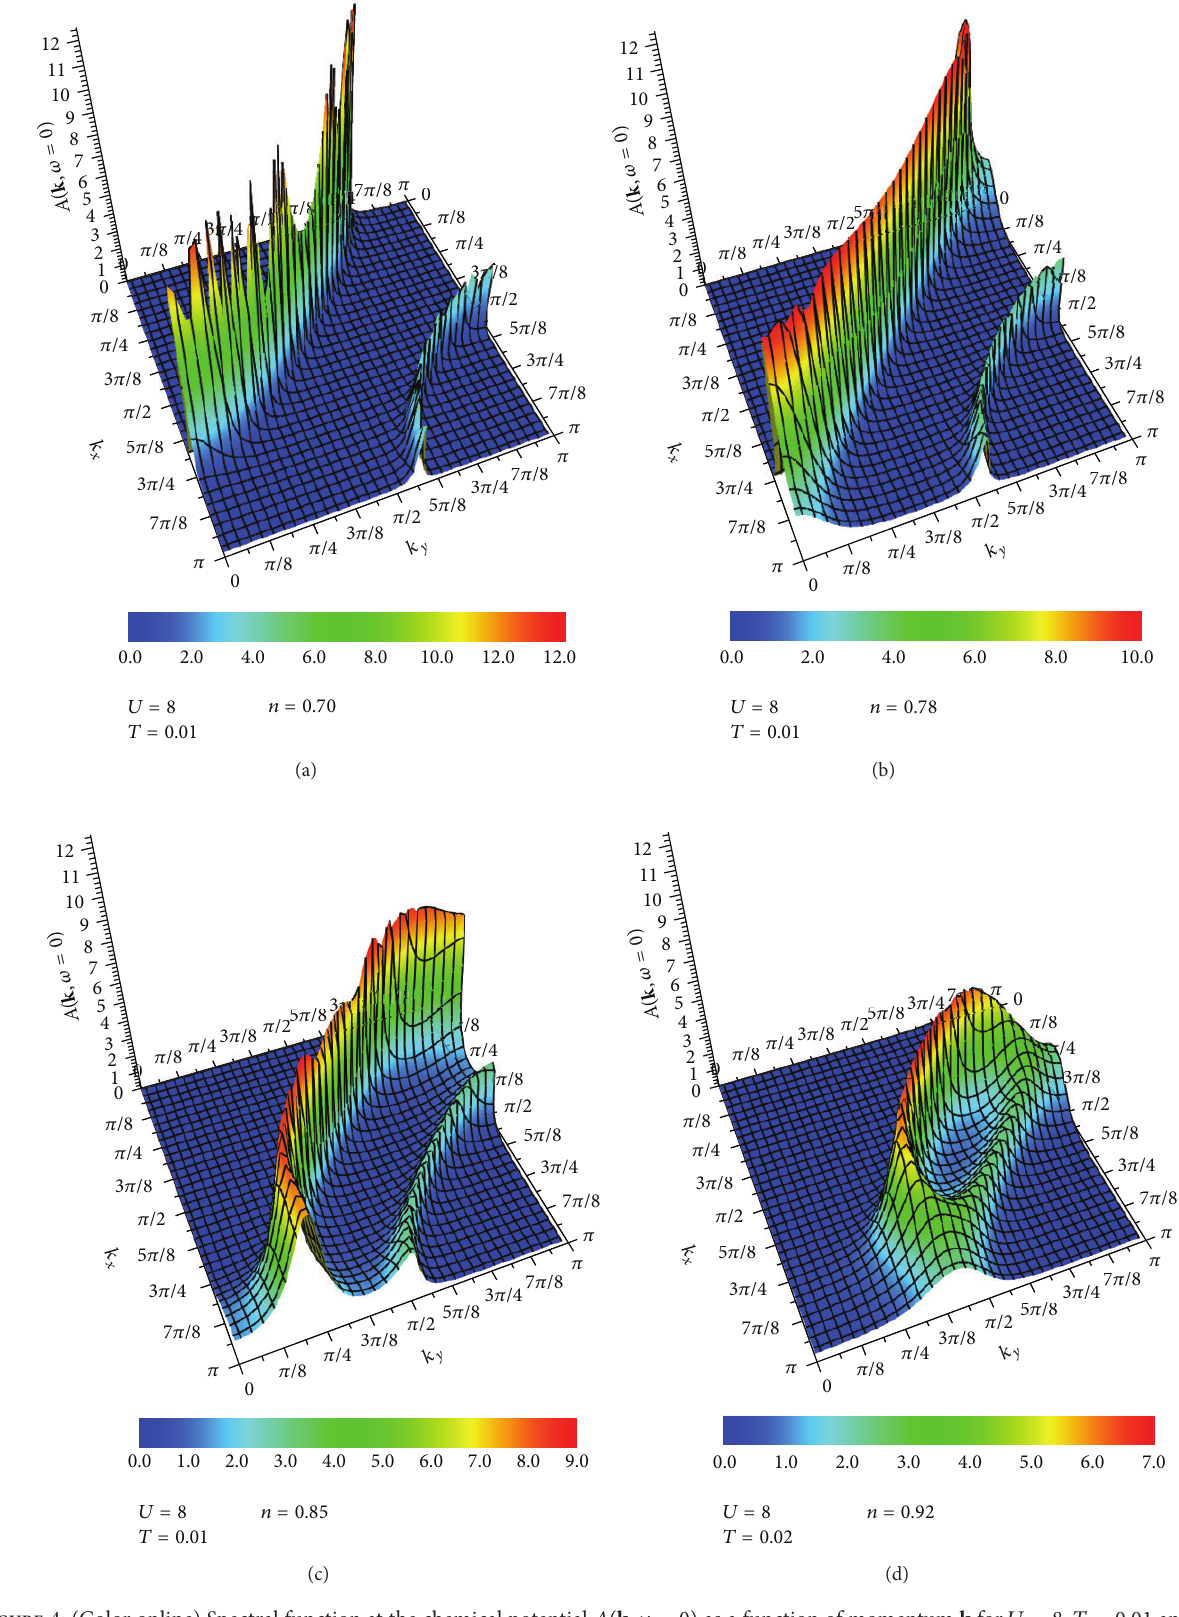
Figure 4: (Color online) Spectral function at the chemical potential 𝐴( k , 𝜔 = 0) as a function of momentum k for 𝑈 = 8 , 𝑇 = 0.01 and (a) 𝑛 = 0.70 , (b) 𝑛 = 0.78 , (c) 𝑛 = 0.85 , and (d) 𝑛 = 0.92 ( 𝑇 = 0.02